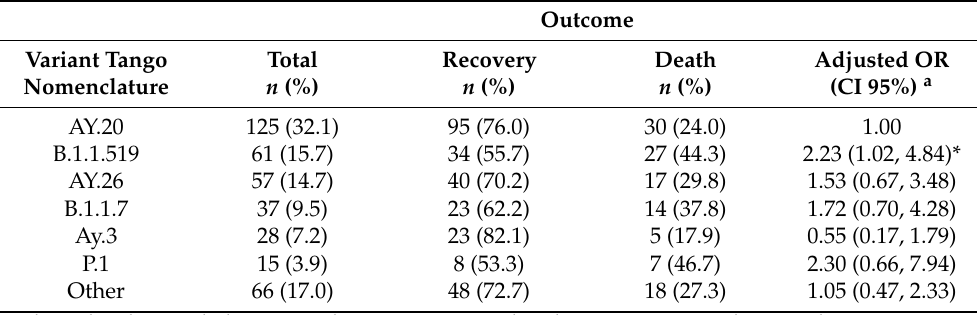
Table 5. Distribution of variants and their association with death as an outcome of COVID-19 ( n =